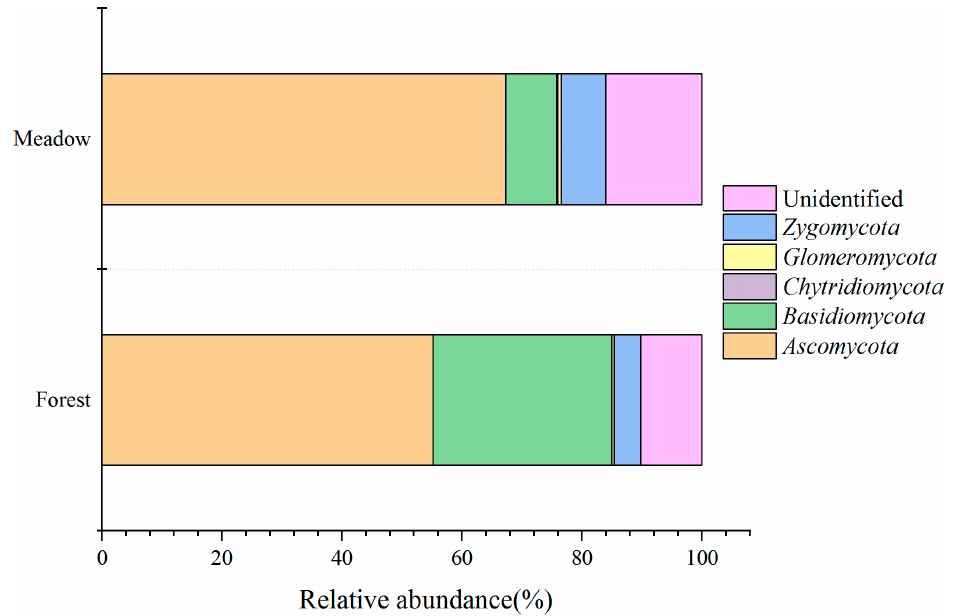
Figure 3. Comparison of fungal community composition between forest (below the treeline) and meadow (above the treeline) at the phylum level.